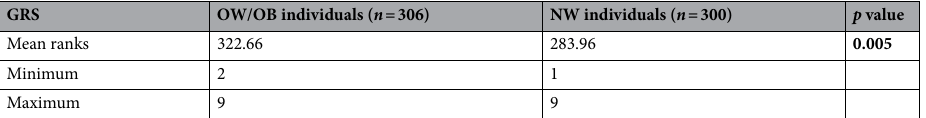
GRS OW/OB individuals ( n =